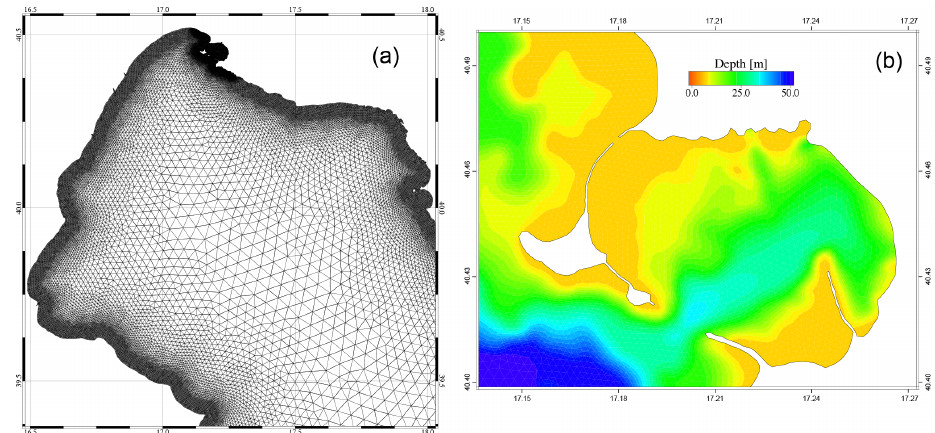
Figure 2. Enlarged views of horizontal grid Gulf of Taranto (a) and bathymetry in Mar Grande of Taranto (b)